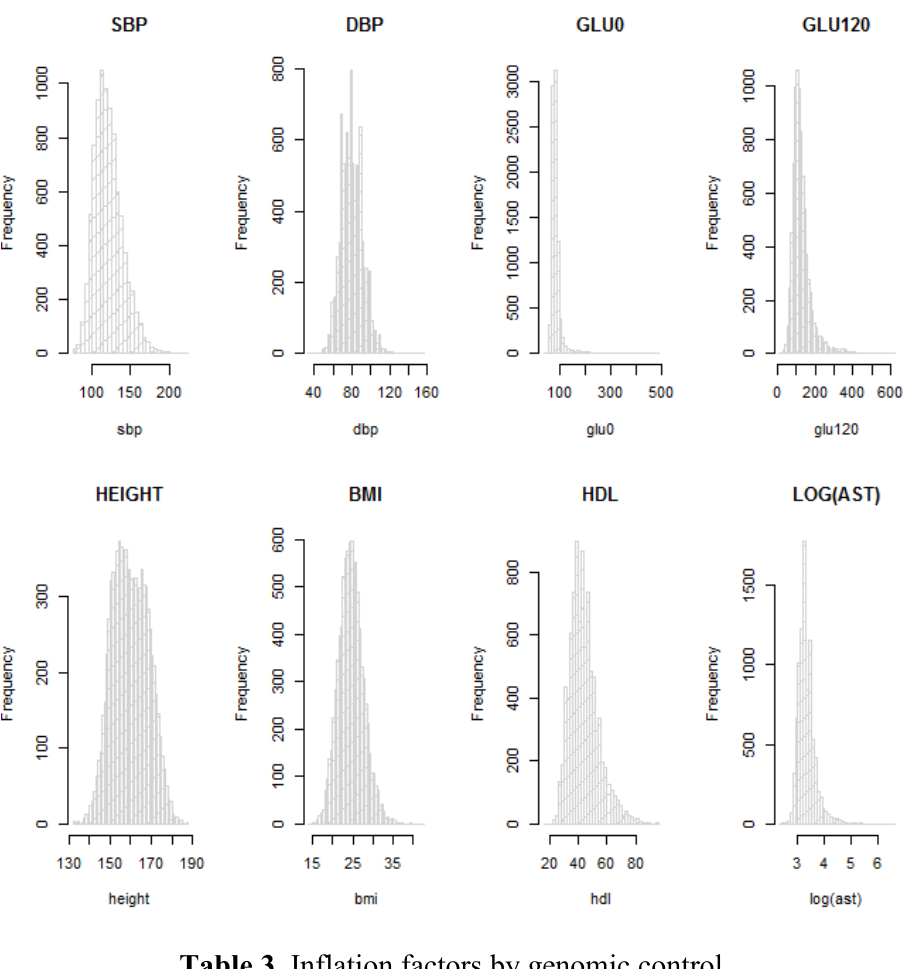
Figure 3. Histograms for SBP, DBP, GLU0, GLU120, HEIGHT, BMI, HDL and log AST in the KARE cohort.